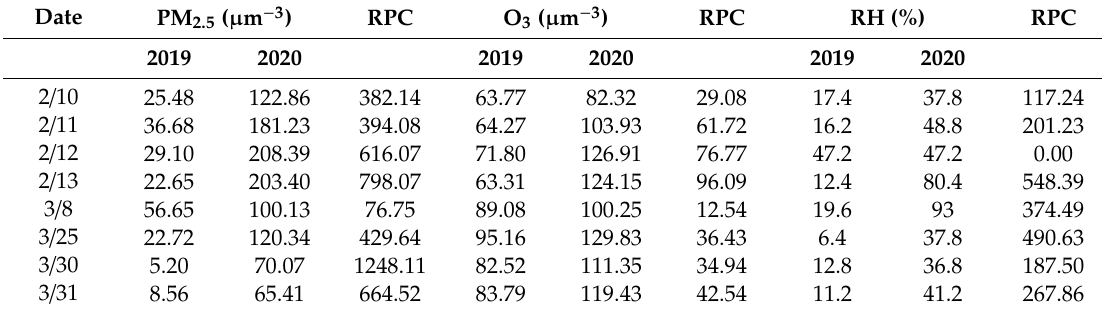
Table 4. Air quality parameters for days of high AOD and PM 2.5 levels in February and March 2020 compared with the same days in 2019. PM 2.5 and O 3 data are from 12 CNEM air quality monitoring stations in Beijing. Relative humidity (RH) data are from http: // weather.uwyo.edu / surface / meteorogram /